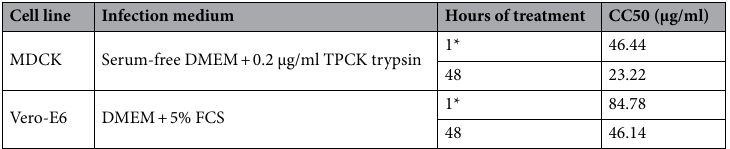
Table 1. Assessment of MB toxicity. *Cell viability was measured 48 h after